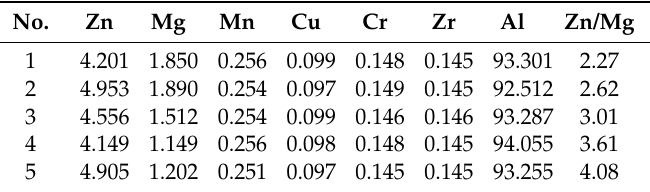
Table 1. Test compositions of the examined alloys (wt.